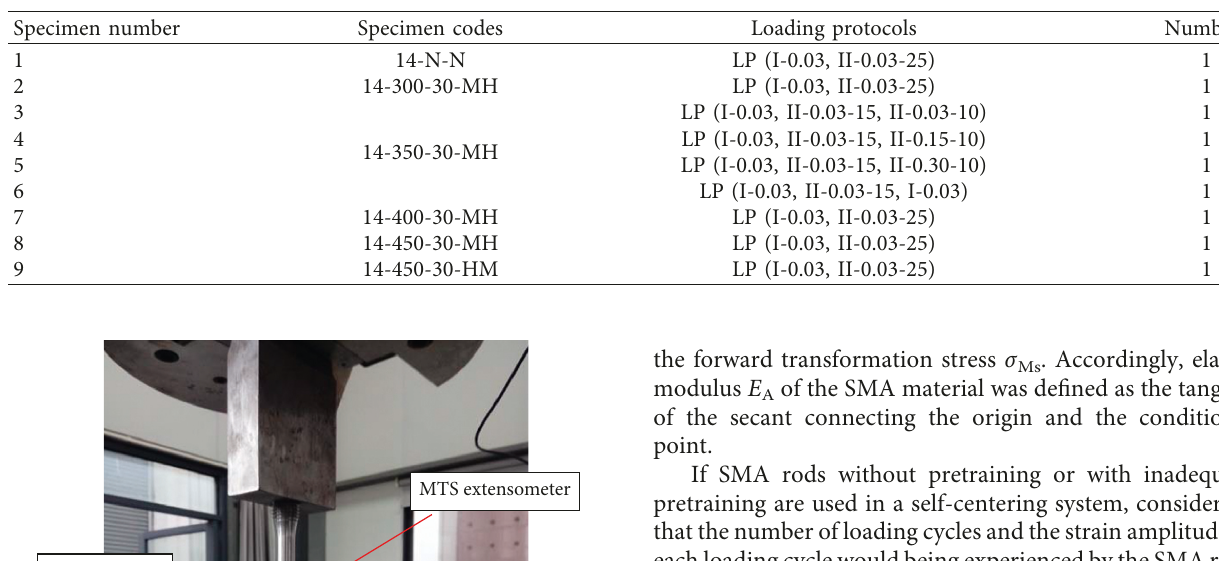
Table 1: Summary of specimens used in this study.